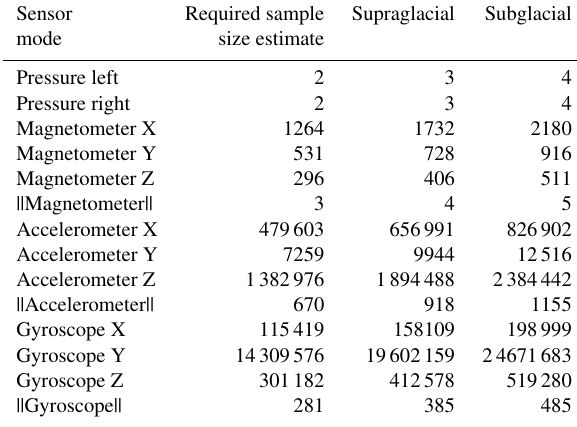
Table 2. Estimated multimodal sample sizes for ± 10% precision and a 95% CI based on measured mean values and standard devi- ations from all deployments ( n = 40), as well as estimated sample sizes for supraglacial and subglacial deployments based on the util- ity rate and the measured mean values and standard